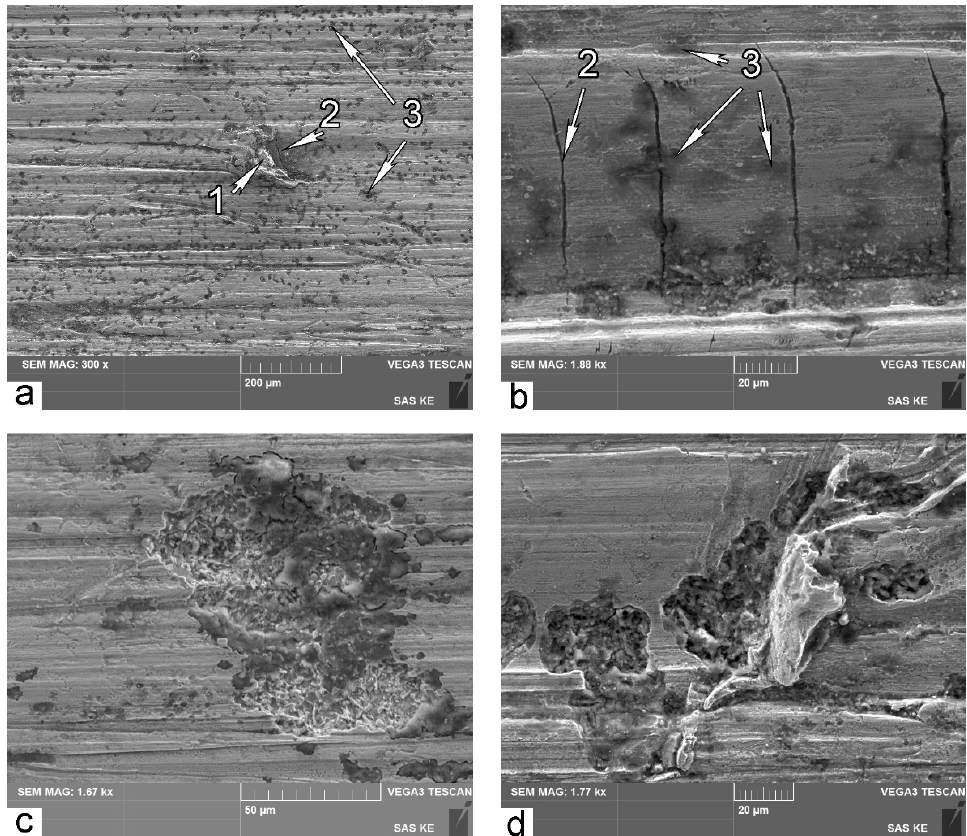
Figure 8. SEM micrographs of surface after wear in B mode: ( a , b , d ) B1000 sample; ( c ) B900 sample; 1—embedded abrasive particle; 2—transverse microcracks; 3—spots of fatigue damage.